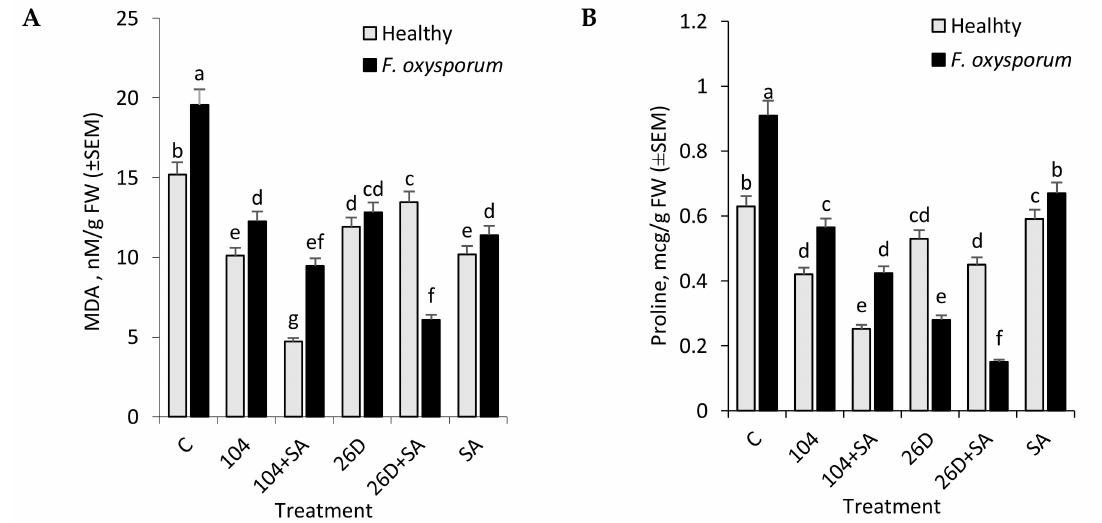
Figure 4. E ff ect of B. subtilis 10-4 (104), B. subtilis 26D (26D), B. subtilis 104 + salicylic acid (SA) (104 + SA), and B. subtilis 26D + SA (26D + SA) on the content of malondialdehyde (MDA) ( A ) and proline ( B ) in F. oxysporum -infected ( F. oxysporum ) and non-infected (Healthy) stored potato tubers (time of storage six months). The bars are the means of three repetitions ± SEM. Di ff erent letters indicate a significant di ff erence between the means at the probability level of p <